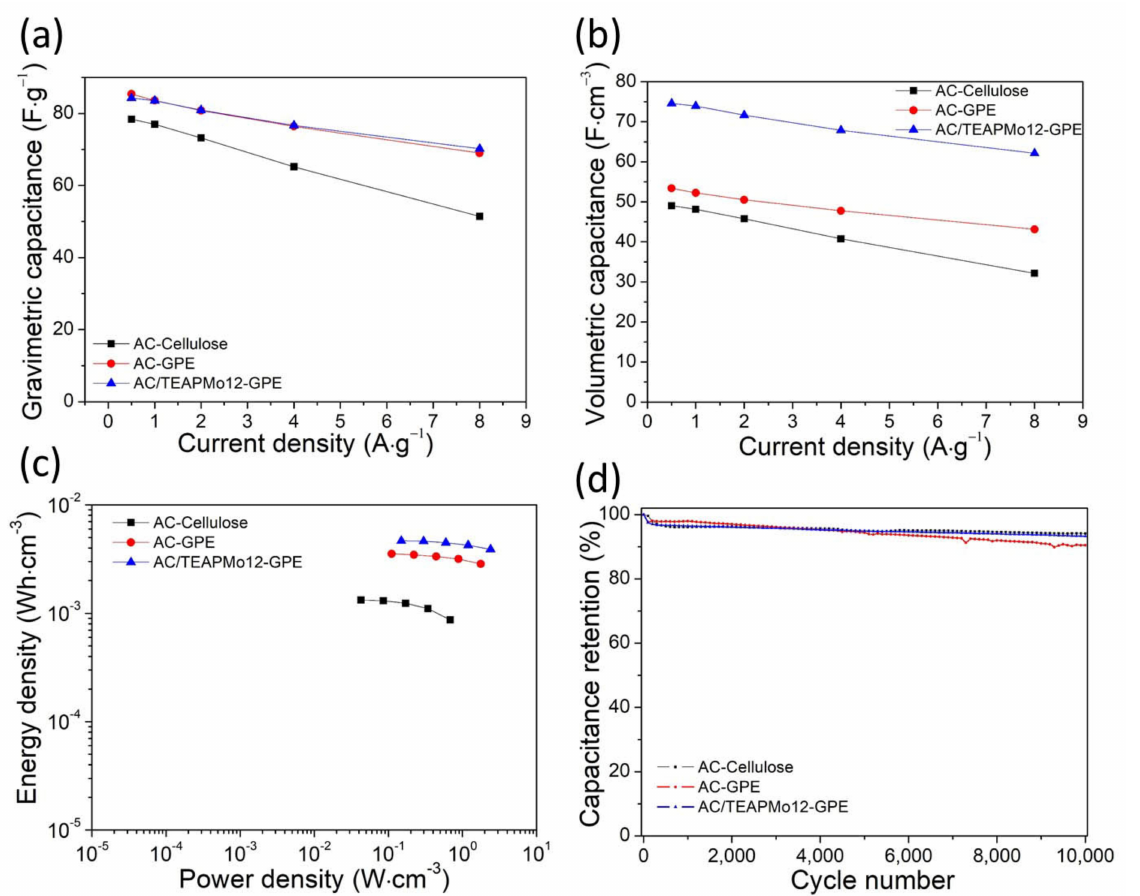
Figure 5. ( a ) Gravimetric capacitance, ( b ) volumetric capacitance, ( c ) ragone plot, and ( d ) cycle stability of AC-cellulose (with the cellulose separator and the liquid electrolyte), AC-GPE (AC with the 12- µ m gel polymer electrolyte), and AC/TEAPMo12-GPE (AC/TEAPMo12 with the 12 µ m gel polymer electrolyte) symmetric